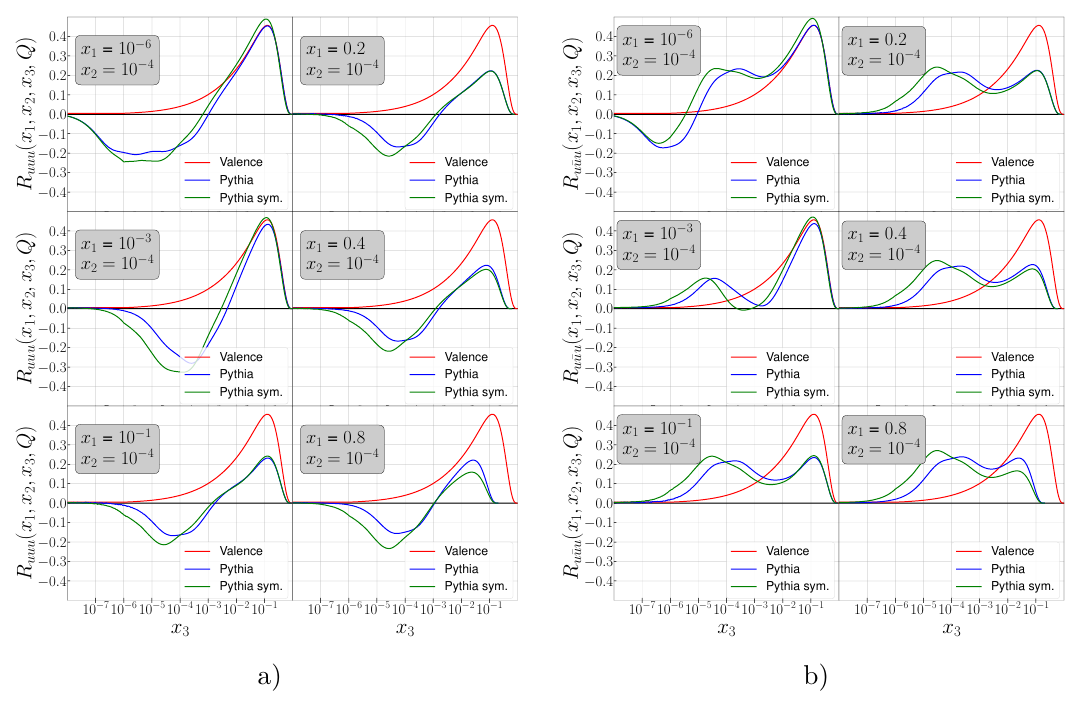
Figure 14 . The responses of the valence u -quark sPDF computed with asymmetric (blue) and symmetric (green) tPDFs: a) uuu flavour combination and b) u ¯ uu flavour